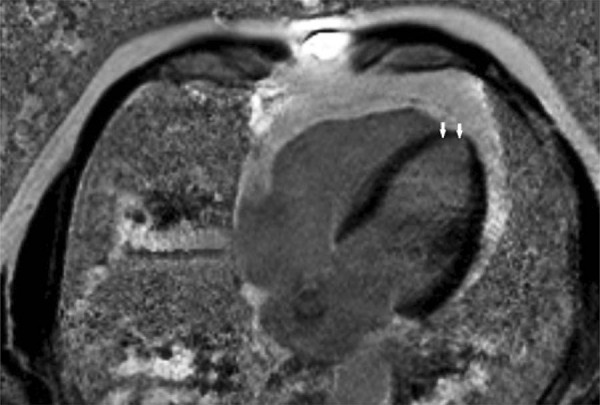
–
Four-chamber delayed-enhancement Phase Sensitive Inversion Recovery (PSIR) image, showing delayed subendocardial circumferential enhancement in the apical region (arrows) of the left ventricle.